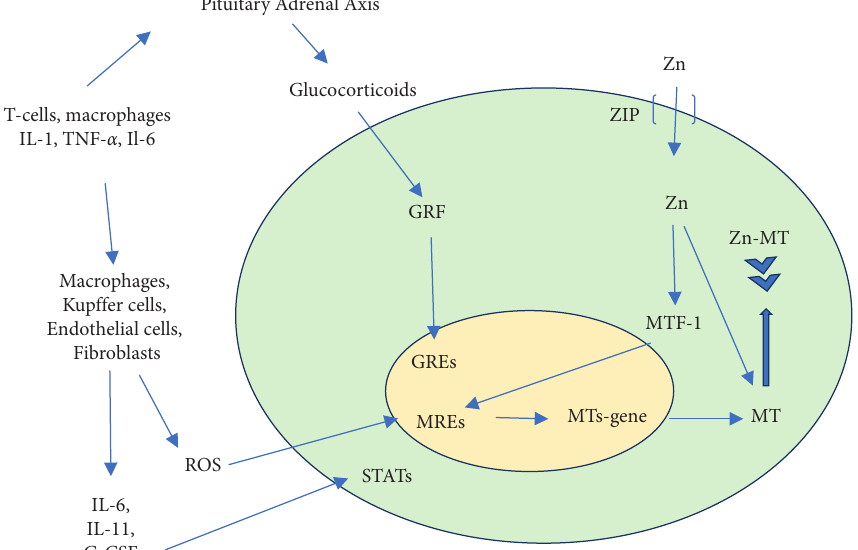
Figure 2: Hepatic MT gene regulation in inflammation. GREs: glucocorticoid responsive elements, GRF: cytoplasmic glucocorticoid receptor complex, MREs: metal response elements, MTF-1: metal transcription factor-1, STATs: signal transducers and activator proteins, and ROS: reactive oxygen species. Adapted from Coyle, et al.